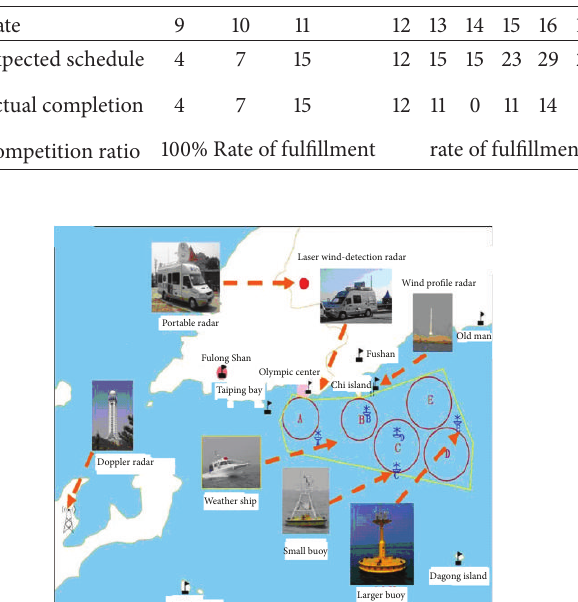
Table 3: Itinerary of Olympic and Paralympic Games.